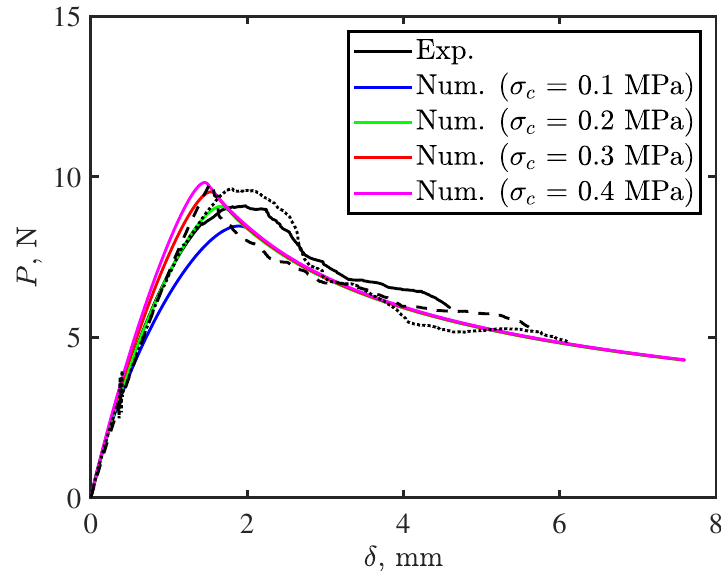
Figure 4. Determining interfacial strength for cohesive elements